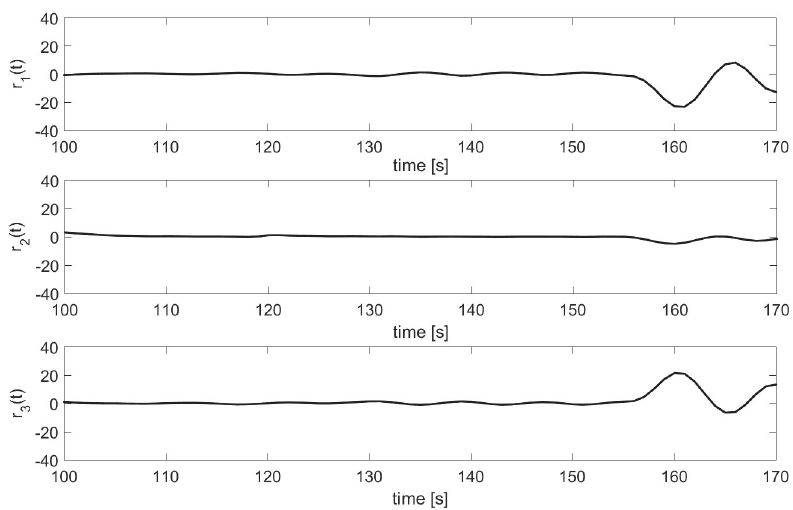
Figure 11. Response of residual to the actuator fault f a 1 .